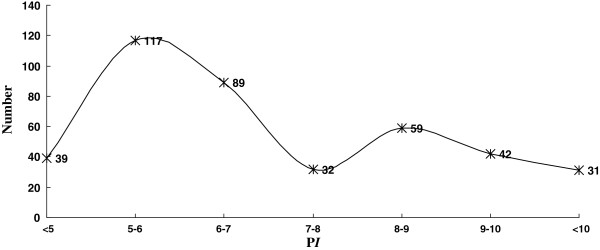
Turning curve shows the global skewness distribution MW about the potential biomarkers.